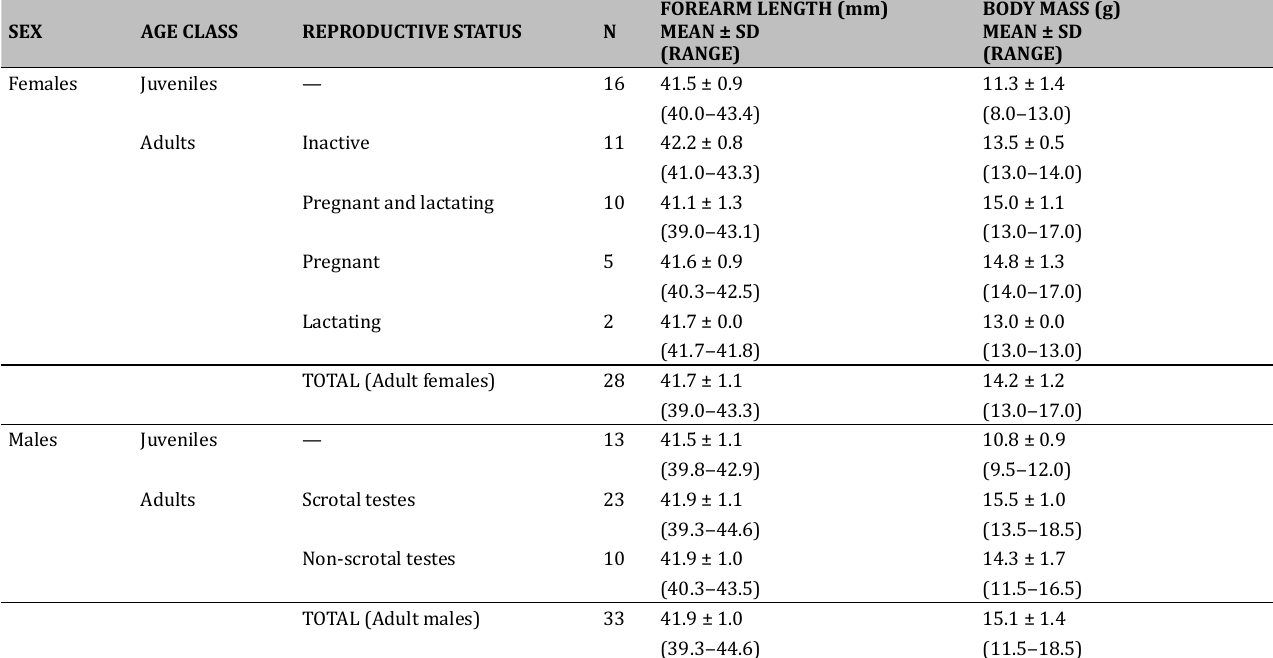
Figure 2. Pregnant female (a) and male with scrotal testes (b)